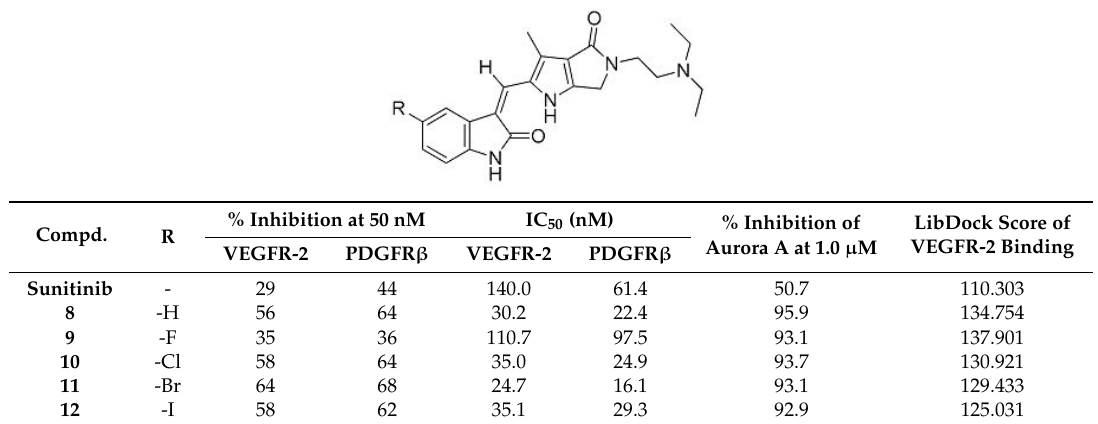
Table 2. Enzymatic activities and LibDock score of 8 – 12 and